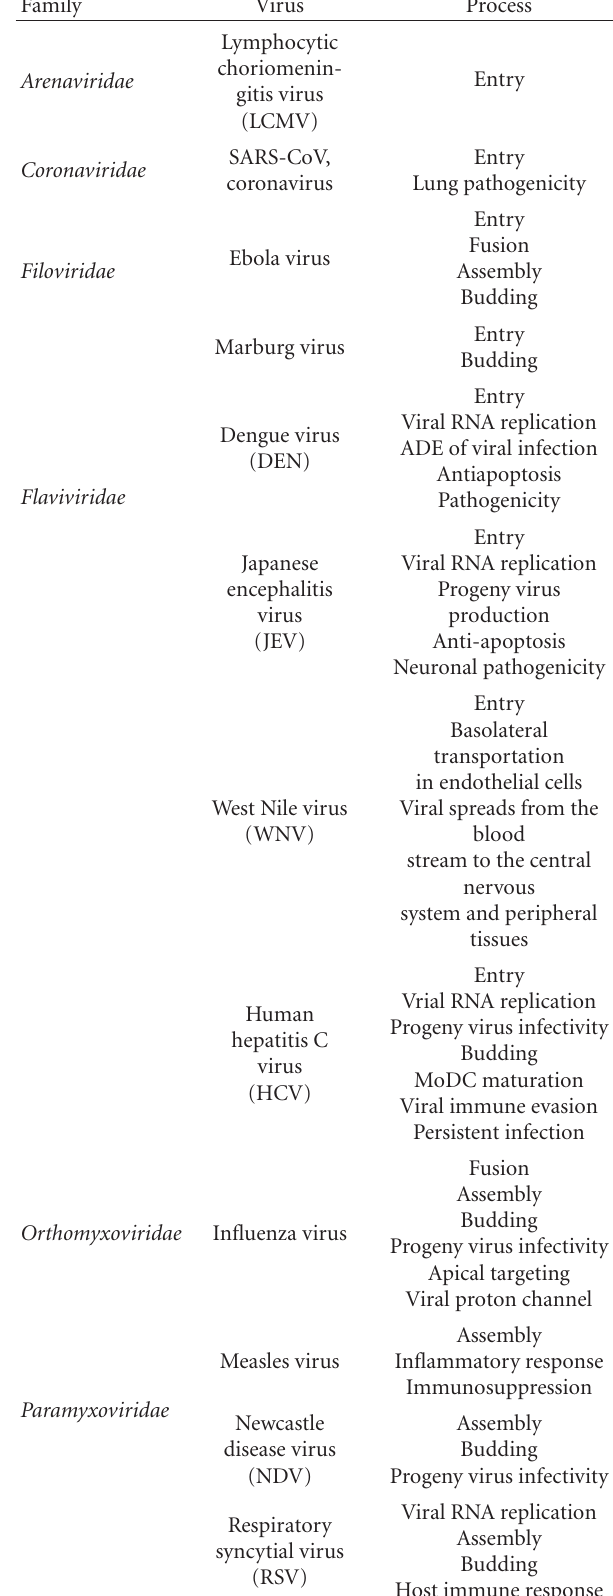
Table 1: Function of membrane rafts in enveloped DNA viruses. Family